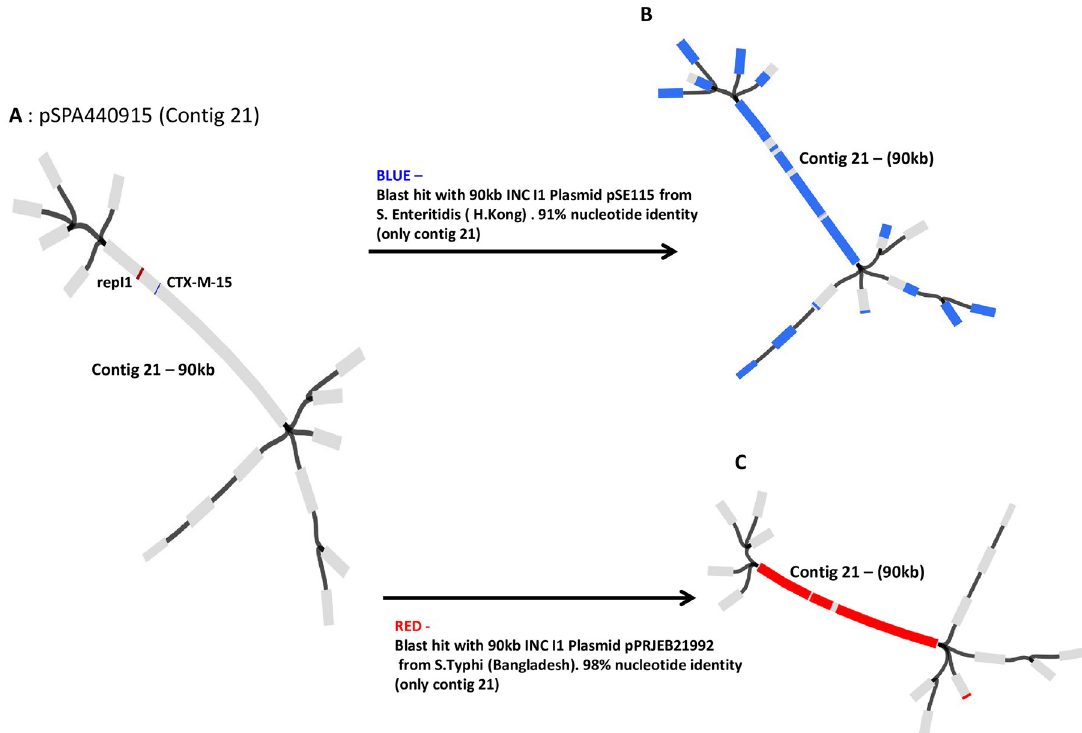
Fig 1. Bandage analysis of the resistant S . Paratyphi A 440915 isolate. A SPAdes assembly of the sequence regions (contigs) associated with drug resistance from isolate 440915. Bandage allows visualization of how contigs (in gray) are possibly connected (in black) to each other. (A) ~90kb plasmid pSPA440915 (contig 21) was assembled from the complete genome sequence of S . Paratyphi A 440915.ESBL resistant bla CTX-M-15 gene (blue) and repI1 indicating IncI1 plasmid replicon were blasted against the assembled pSPA440915, and their location determined (on contig 21). (B) Plasmid pSE115 from S . Enteritidis (Gene Bank accession number: KT868530) was blasted against pSPA440915. Blast hits in blue (only in contig 21) indicates a 91% sequence similarity between both plasmids. repI1 present. bla CTX-M-14 present instead of a bla CTX-M-15 gene. Blast Hits (blue) outside of contig 21 –mainly short repeat sequences (insertion elements). (C) Plasmid pPRJEB21992 from S . Typhi (EMBL-EBI BioProject PRJEB21992) was blasted against pSPA440915. Blast hits in red (only in contig 21) indicates a 98% sequence similarity between both plasmids, including the repI1 , bla CTX-M-15 and bla TEM-191